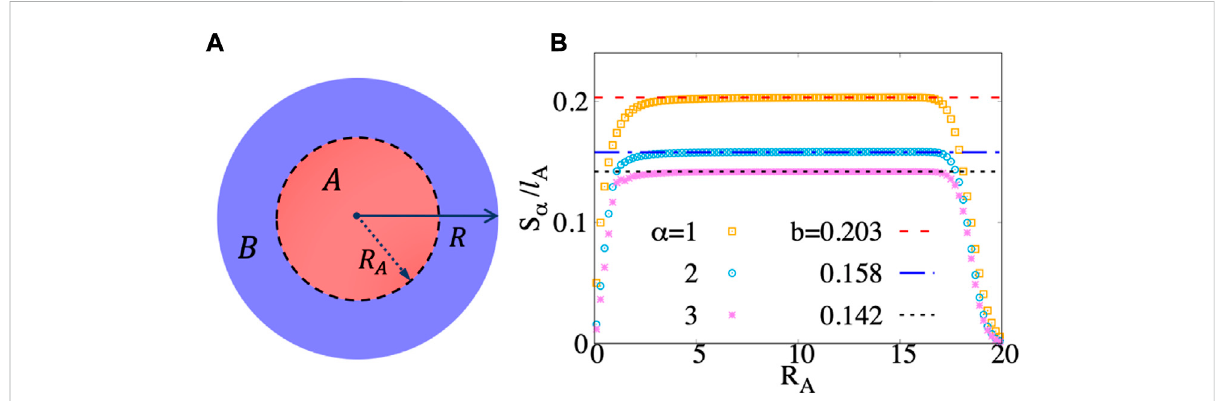
FIGURE 1 (A) Smooth circular cut with radius R A in a fi nite disk. (B) Prefactor of the area law for α -Rényi entropies. The well-developed plateau appears when R A is larger than 1.0 l B and smaller than the radius of the